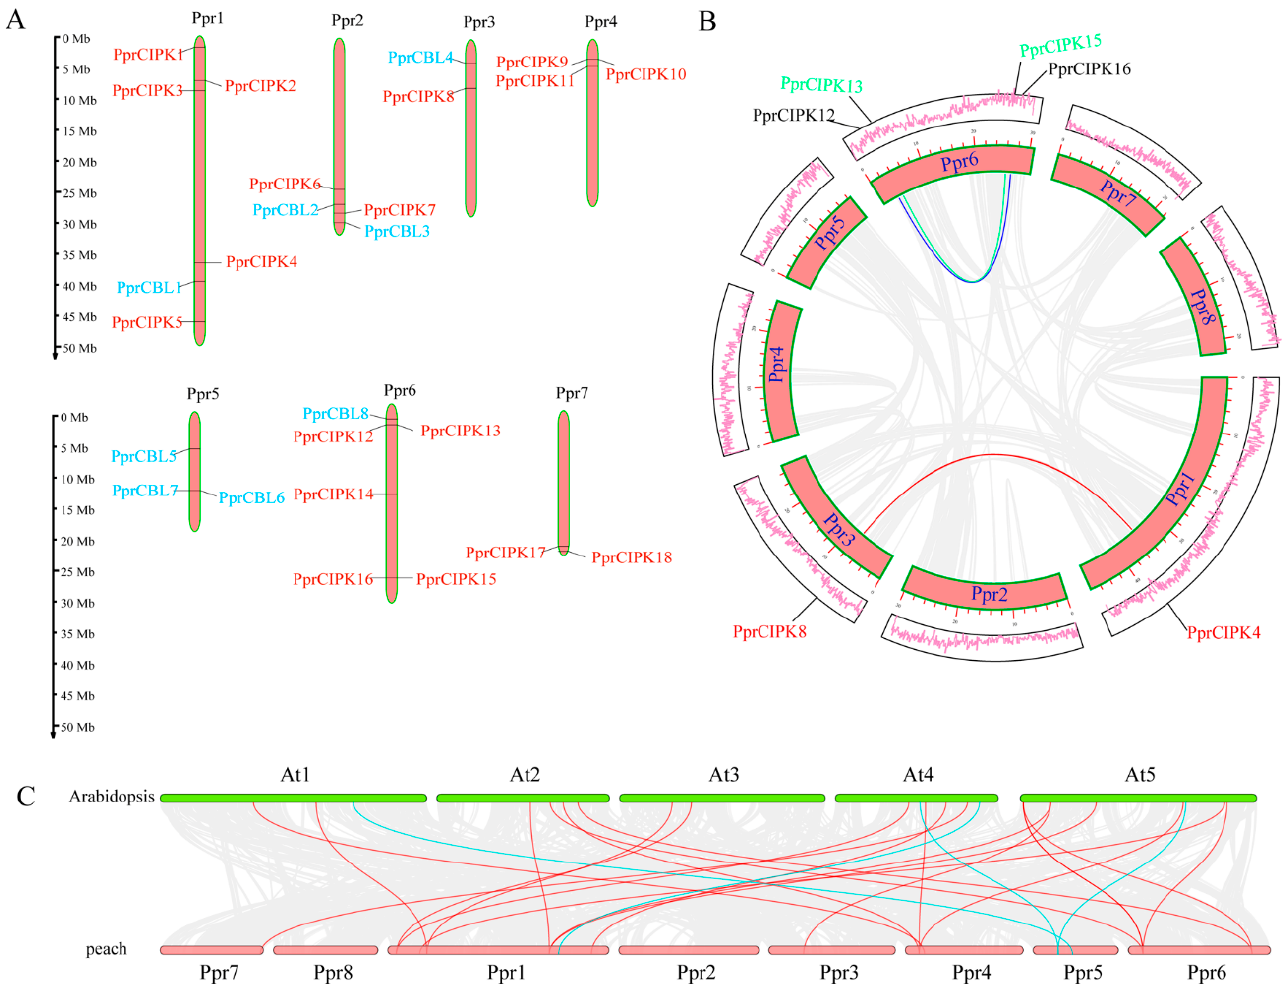
Figure 3. Genomic analysis of peach CBL and CIPK genes. ( A ) Distribution of CBL and CIPK genes in the peach genome. The orange bars represent peach chromosomes. ( B ) Collinearity analysis of the CBL and CIPK members in the peach genome. The lines represent the segmentally duplicated pair. ( C ) Comparison of collinearity between peach and Arabidopsis genomes. The red lines indicate collinearity between peach and Arabidopsis CIPK members, and the blue lines indicate collinearity between peach and Arabidopsis CBL members.